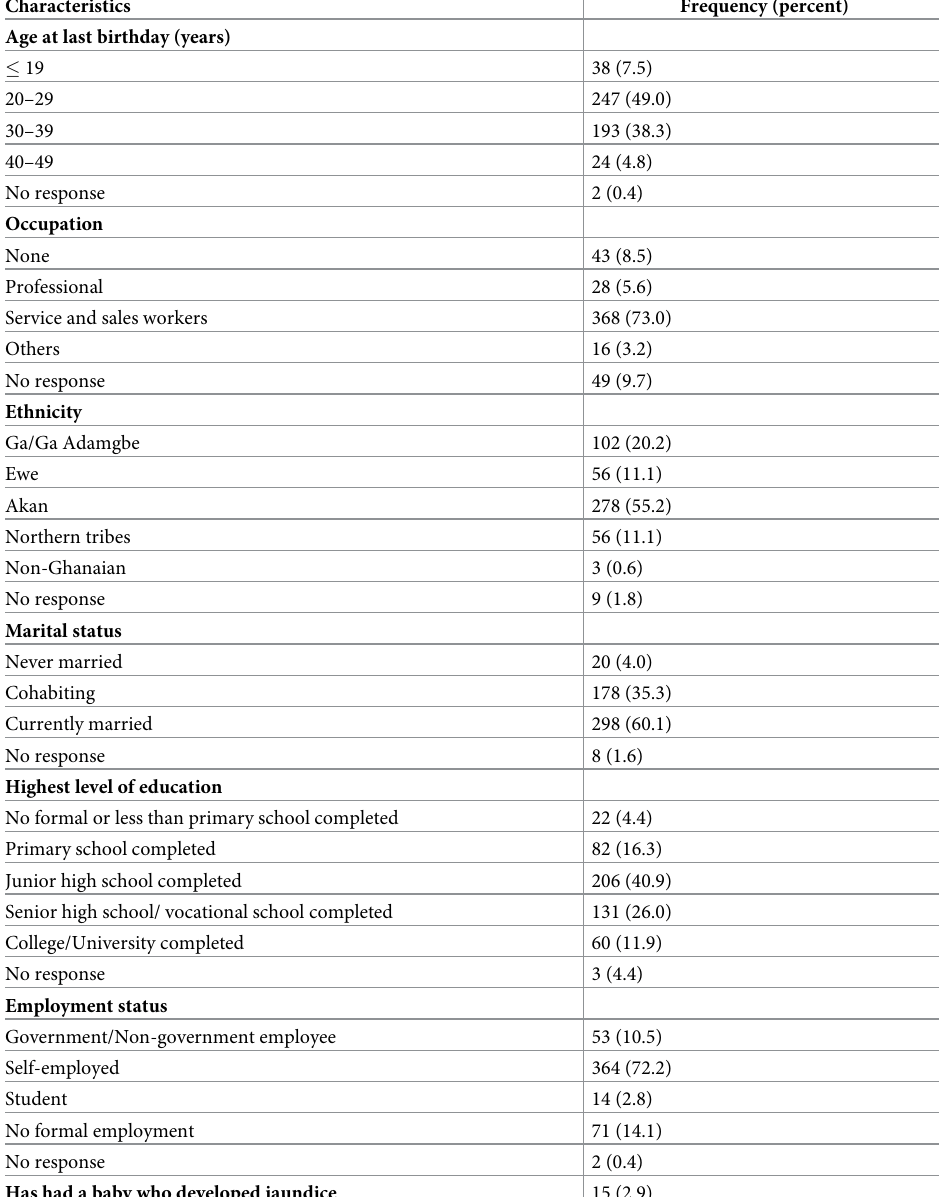
Table 1. Profile of mothers from antenatal clinics and postnatal wards in Greater Accra and Eastern Regions of Ghana (N = 504).